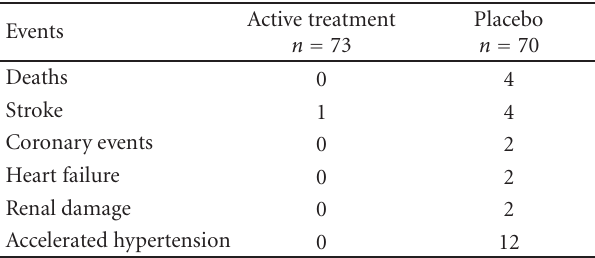
Table 1: Fatal and nonfatal events at the VA trial in patients with severe hypertension receiving active treatment (HCTZ, reserpine, and hydralazine) or placebo (modified from the VA collaborators